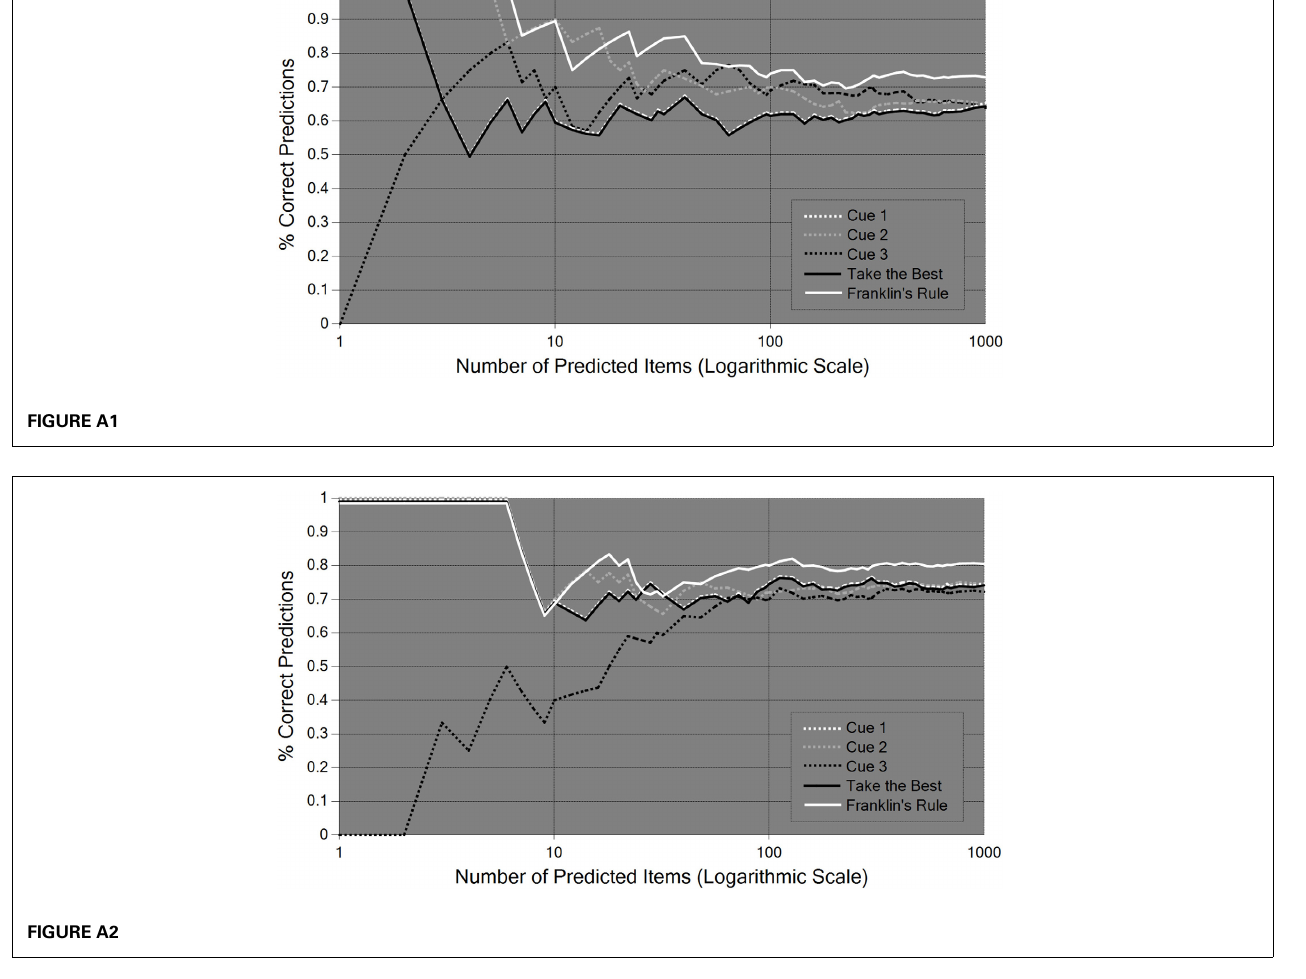
FIGURE A1 + A2 | TTB against Franklin’s rule in a binary prediction tournament with known validities which are conditionally dependent. Figure A1 with low redundancy and Figure A2 with high redundancy of cues. In both cases, Franklin’s rule predicts better than TTB